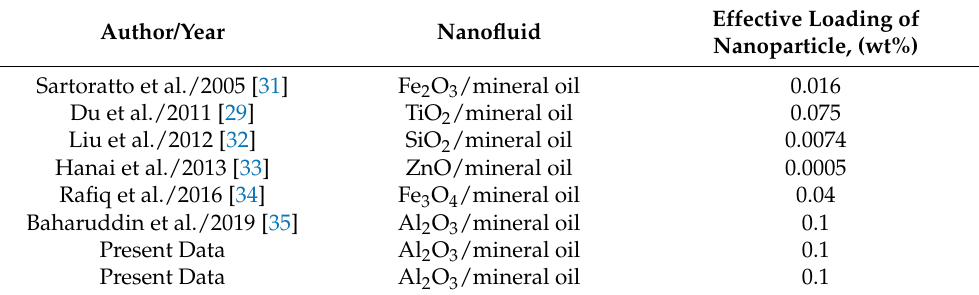
Figure 7. Comparison of the present experimental data of AC breakdown voltage with previous findings. Table 3. Comparison of the present experimental data of the types of nanofluids and effective loading of nanoparticles in enhancing AC breakdown